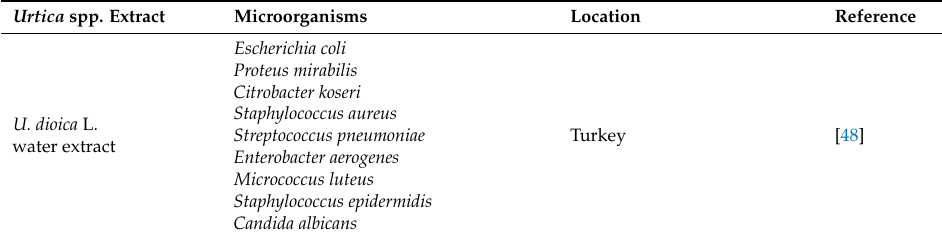
Table 4. In vitro activity of Urtica spp. against